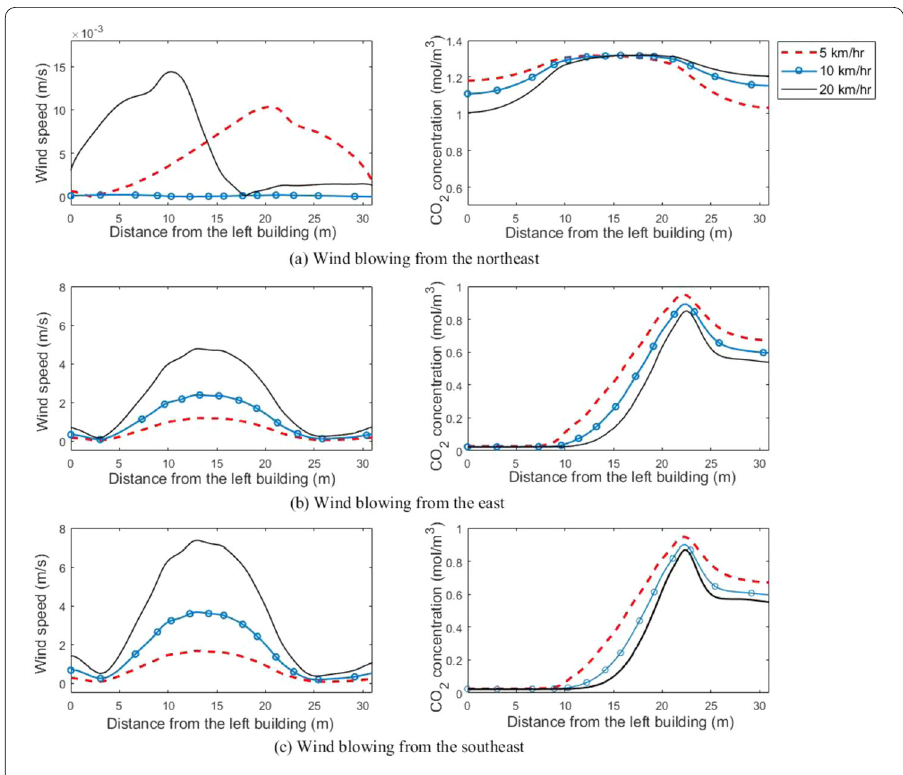
Figure 7 Comparison of wind-velocity profiles and CO 2 -concentration profiles at 2-meter height above the ground obtained from model with various conditions of the inlet wind speed and its blowing